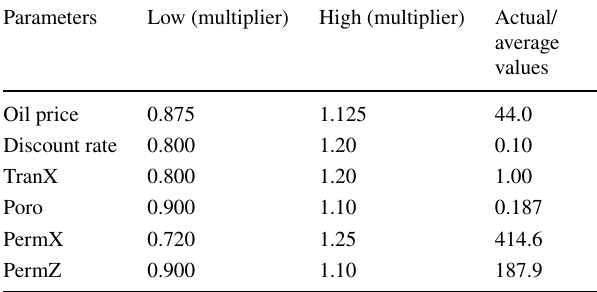
Fig. 21 NPV versus spacing arrangements for 4 vertical infill wells located at different well spacings Table 5 Summary of the economic and reservoir parameters varied during the uncertainty